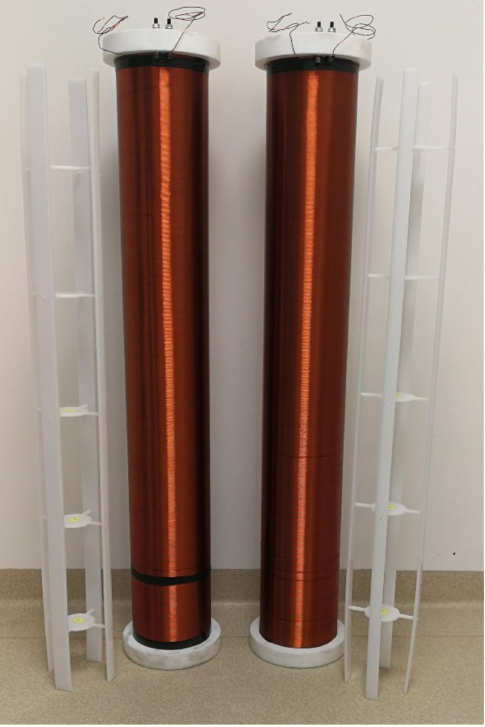
Figure 7. Exposure and control coils with supporting